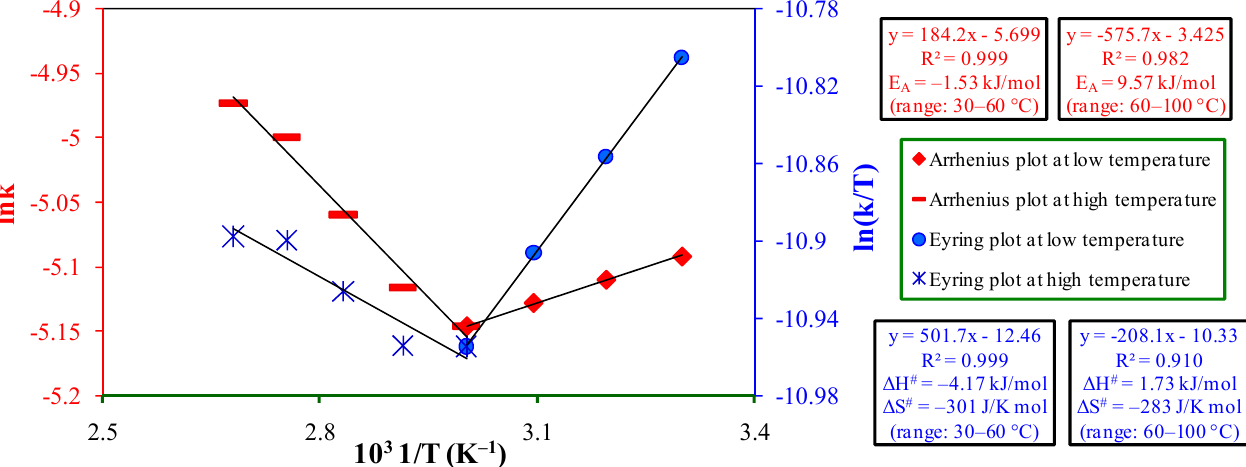
Figure 10. Thermodynamic parameters of activation for the adsorption of RBV-5R by SCB.